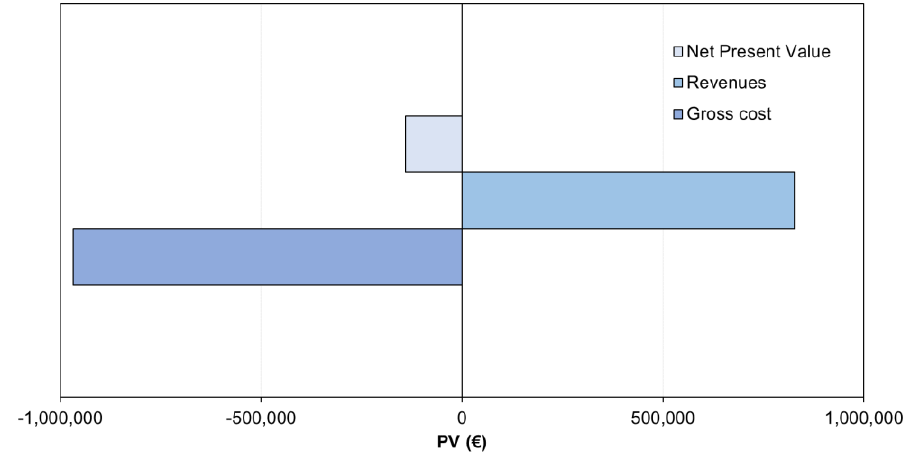
Figure 6. Gross cost, revenues and net present value for the nitrogen recovery scenario under study.